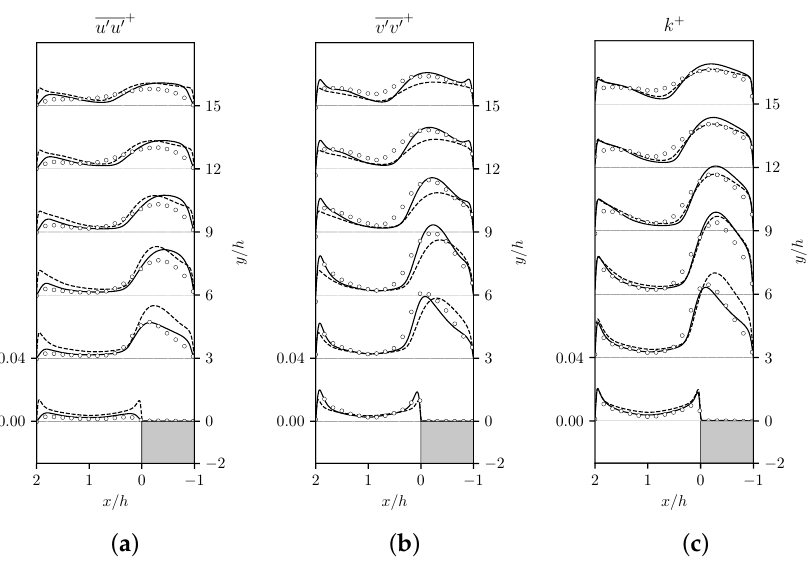
Figure 10. Profile of dynamical fields: wall-normal normal stress uu + ( a ), streamwise normal stress vv + ( b ), and turbulent kinetic energy k + ( c ). : Simulation results with the anisotropic four-parameter (A4P) model; : Simulation results with the isotropic four-parameter (4P) model. DNS data.